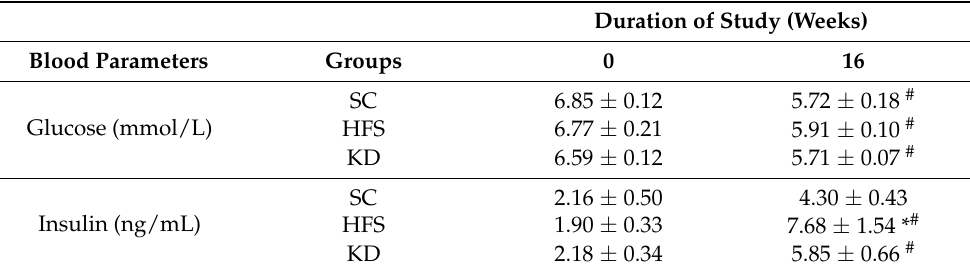
Table 4. Glycemia and insulinemia levels at the beginning (week 0) and at the end of the dietary intervention (week 16) in SC-, HFS-, and KD-fed